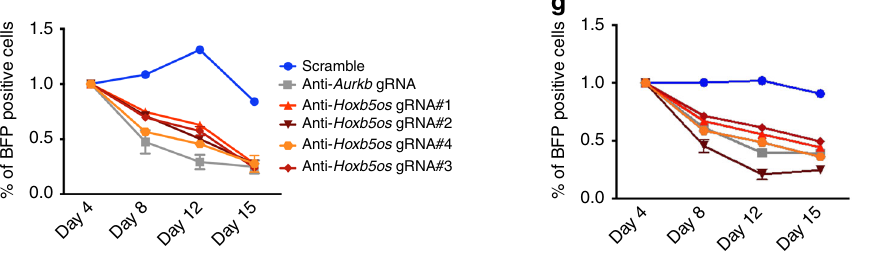
Fig. 3 Functional signi fi cance of HOXB-AS3 expression in AML patient blasts. a Relative HOXB-AS3 RNA expression in AML blasts from three patients with NPM1 mutations ( NPM1 mut), treated with scramble versus anti- HOXB-AS3 gapmers ( HOXB-AS3 KD). b Number of colonies formed by scramble versus HOXB-AS3 KD AML patient blasts in colony-forming unit assays. Experiments were conducted in triplicates. c Relative HOXB-AS3 RNA expression in AML blasts from a NPM1 mut AML patient treated in vivo with scramble or anti- HOXB-AS3 gapmers. d Schematic representation of the study design testing therapeutic value of in vivo HOXB-AS3 KD. e Kaplan – Meier curves depicting survival of NSG mice xeno-transplanted with blasts of NPM1 mut AML patients treated with scramble ( n = 11) or anti- HOXB-AS3 gapmers ( n = 11). f , g Frequency of BFP-expressing cells transduced with either anti- Hoxb5os gRNAs or non-targeting controls over a 15-day period of competitive co-culture with non-transduced cells of the f Rosa26 Cas9/ + ; Npm1 cA/ + ;Flt3 ITD/ + or the g Rosa26 Cas9/ + ; Npm1 cA/ + ; Nras G12D/ + murine AML cell lines. gRNAs targeting the Aurkb gene were used as a pan-essential positive controls. In ( a – c ), P values were calculated using paired two-sided t -tests. Heights of boxplots indicate mean values with standard deviation. Error bars indicate highest and lowest values in each population. In ( e – g ), P values were calculated using the log-rank test. Source data are provided as a Source Data fi